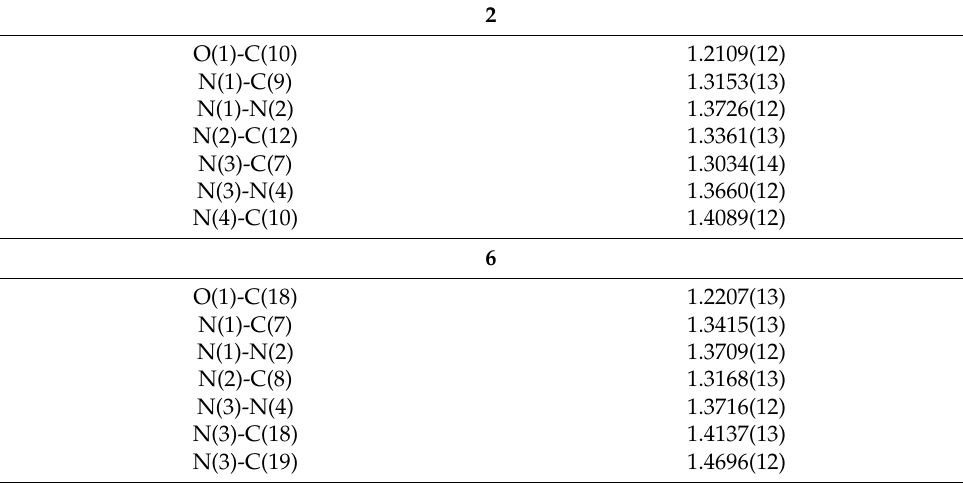
Table 2. Selected bond lengths [Å] and angles [ ◦ ] for 2 .